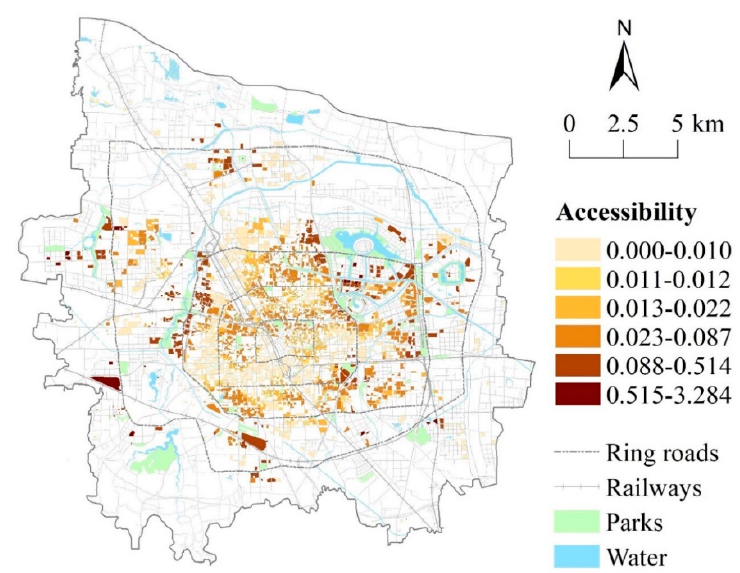
Figure 6. Spatial distribution of park accessibility value.